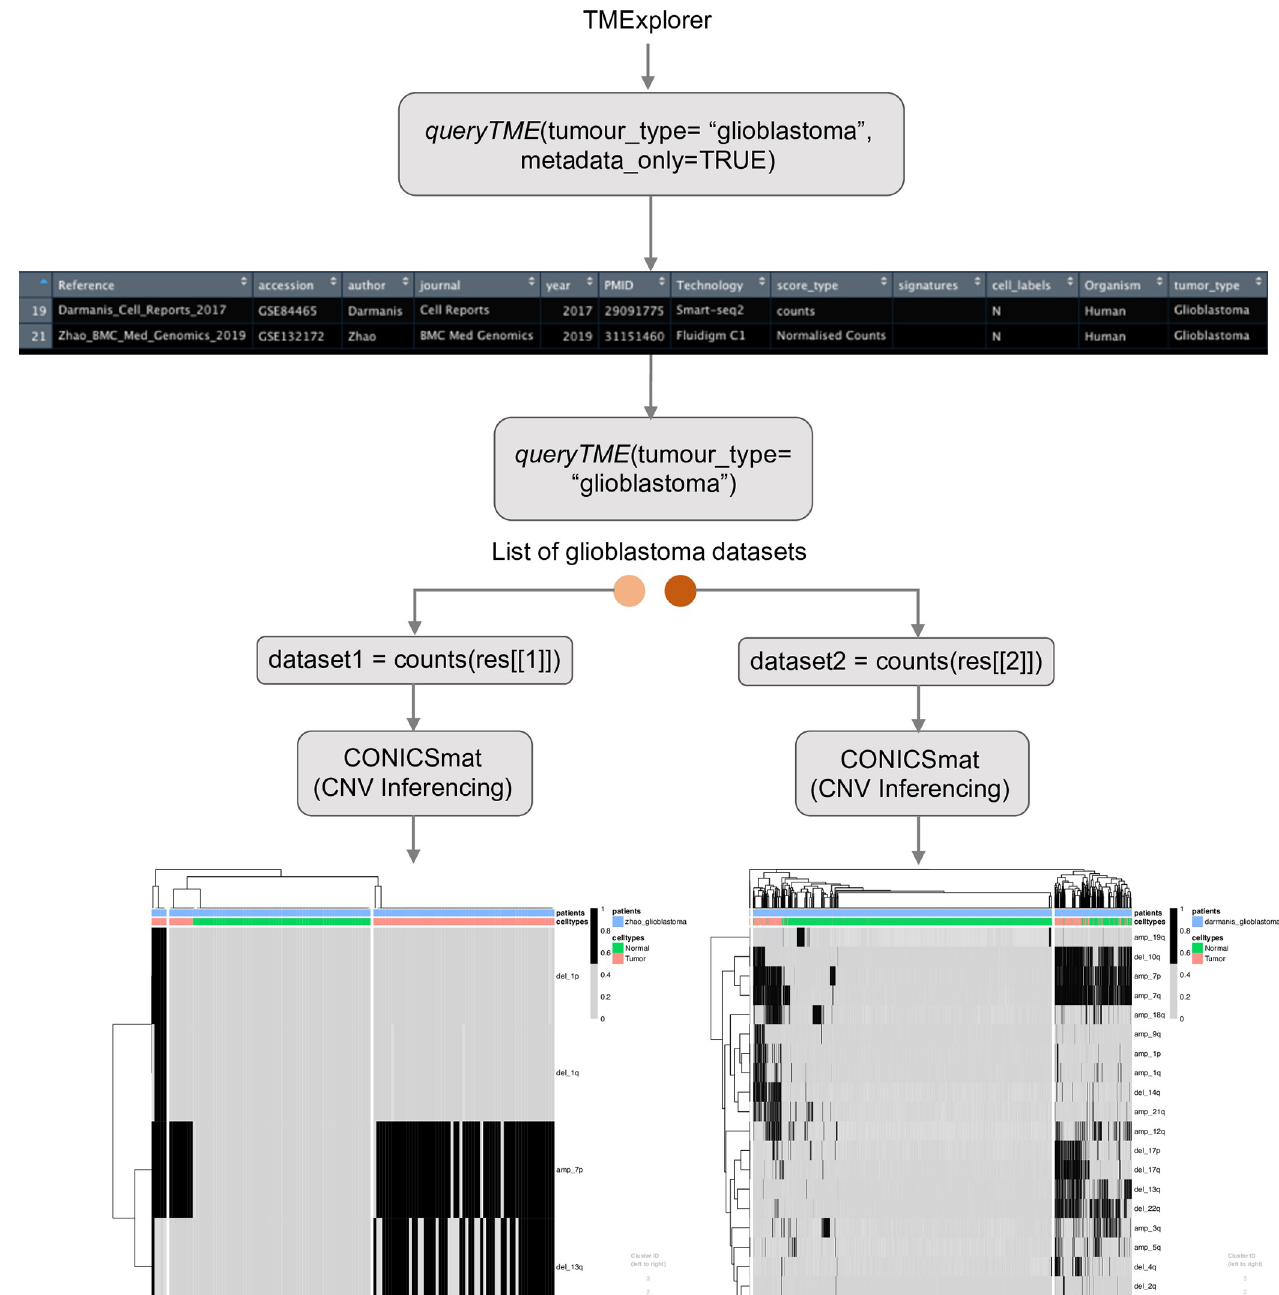
Fig 8. A case study on using TMExplorer for inferring CNVs. A case study showing how TMExplorer can be used to obtain multiple datasets for a specific tumour type, to be used with CNV-based separation methods, such as CONICSmat. QueryTME returns datasets of a specific tumour type, such as Glioblastoma. These datasets can then be inputted directly into large-scale CNV inferencing methods, such as